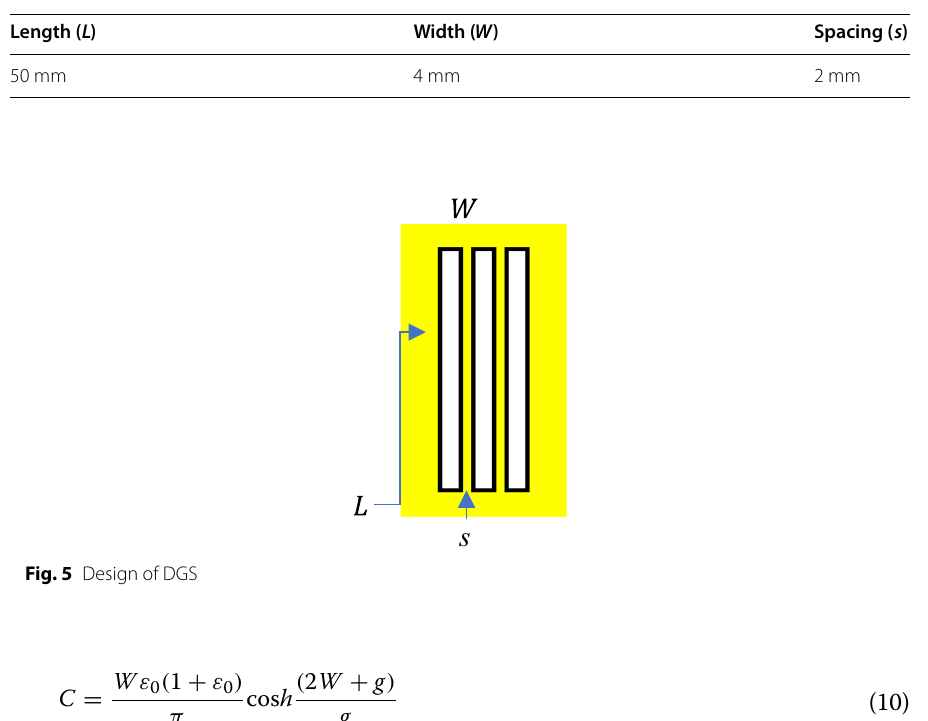
Table 4 Dimension of